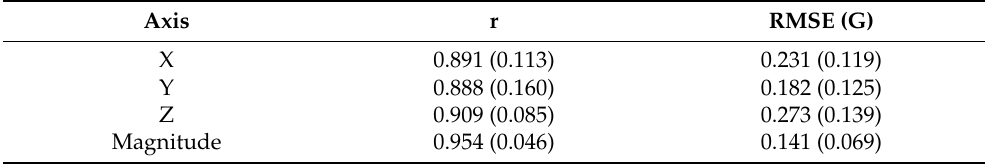
Table 3. Mean and standard deviations of correlation coefficient (r) and root mean squared error (RMSE) during